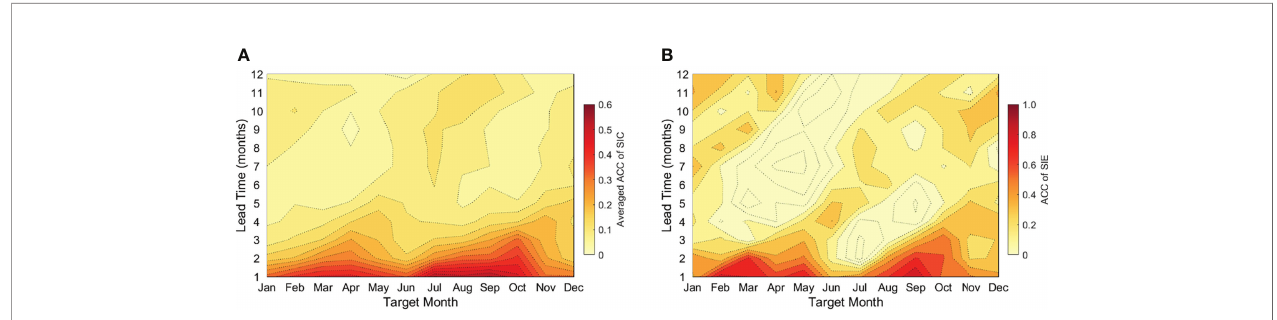
FIGURE 3 | Persistence of the Arctic SIC (A) and total SIE (B) based on the anomaly correlation coef fi cients (ACCs) of monthly SIC and SIE in January to December at different lead times. Note that ACCs in (A) are the regional averaged values for SIC on all grid points. Data of SIC and the calculated SIE during 1979 – 2020 are from